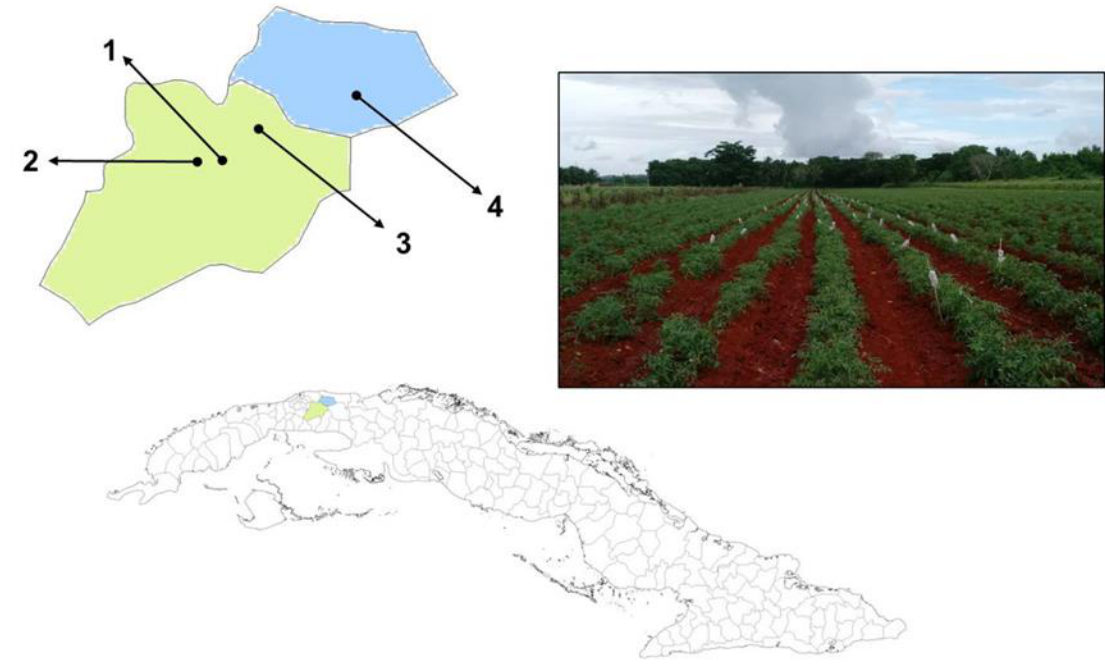
Figure 1. Location of the four tomato fields in the municipalities of San José de las Lajas (green) and Jaruco (blue) in the province of Mayabeque, Cuba. The picture shows the bagging experiments in the flowers of tomato